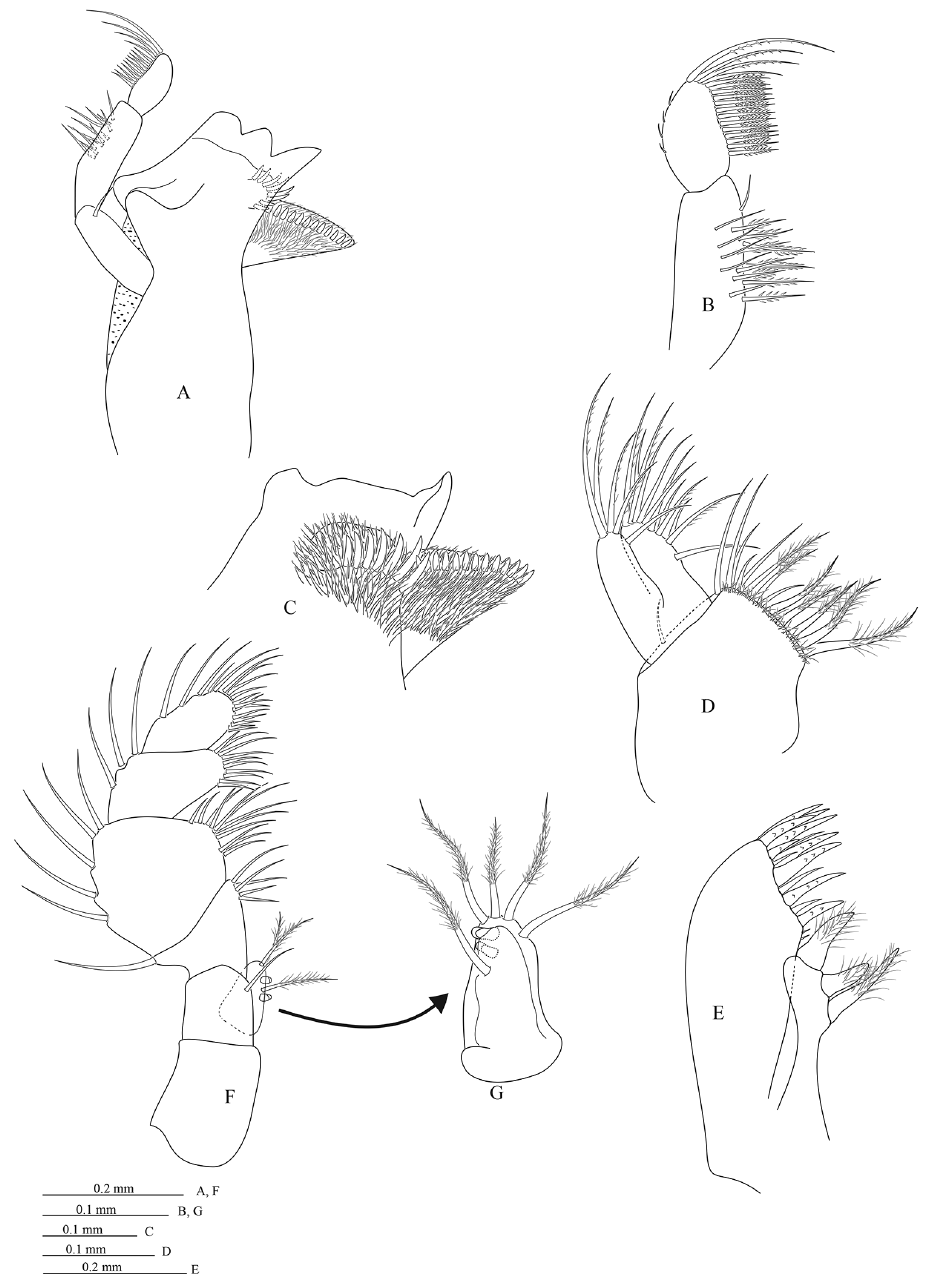
Figure 3. Cirolana phuketensis sp. n., male paratype (PSUZC–CR0286-02) (5.1 mm) A right mandible B dorsal view of article 3 of right mandible palp C distal part of left mandible D right maxilla E right maxillula F right maxilliped G